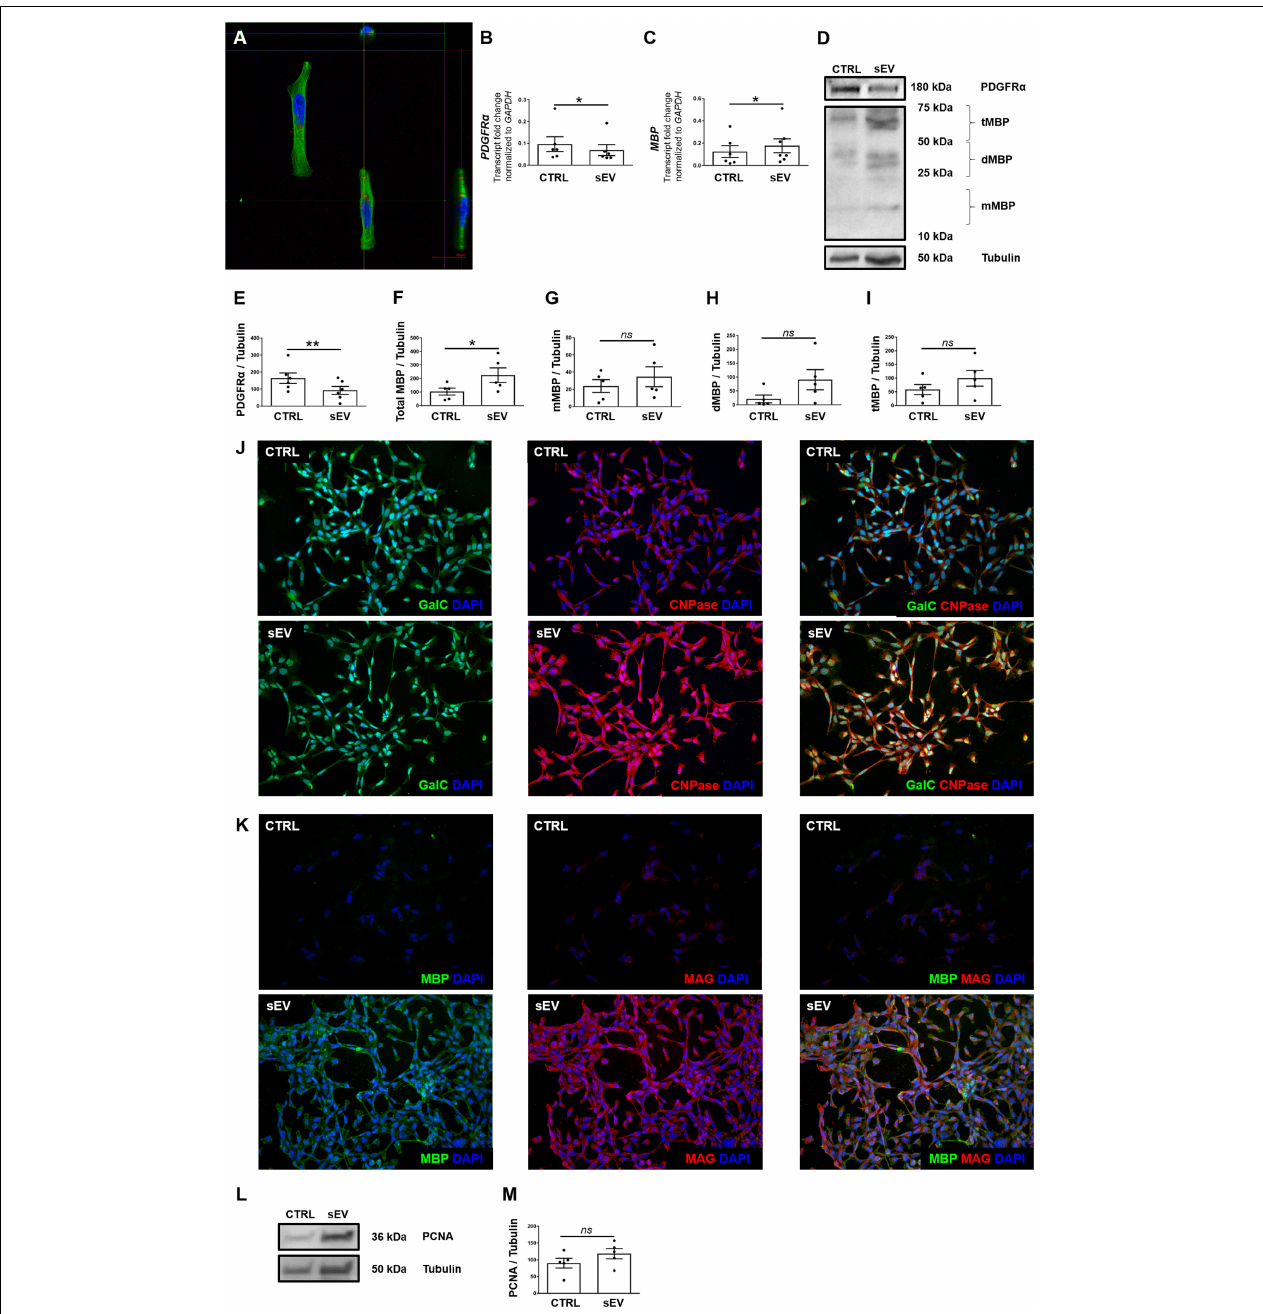
FIGURE 1 | WJ-MSC-derived sEV co-localize with MO3.13 cells and drive their maturation. (A) Representative confocal Z-stack section after co-culture of sEV with MO3.13 cells for 4 h. To label sEV, the fluorescent membrane dye PKH26 (red) was used. MO3.13 cells were stained with β -tubulin (green). Their nuclei were counterstained with 4 (cid:48) ,6-diamidino-2 (cid:48) -phenylindole-dihydrochloride (DAPI) (blue). (B,C) Transcription of PDGFR α ( n = 6) and MBP ( n = 6) by MO3.13 cells either left untreated or co-incubated with 0.5 µ g/mL sEV for 5 days. (D) Representative western blots of PDGFR α and MBP expression by MO3.13 cells either left untreated or co-cultured with 5 µ g/mL sEV for 5 days. (E) Quantification of PDGFR α protein expression by MO3.13 cells after 5 days ( n = 6) (F–I) Quantification of MBP protein expression by MO3.13 cells after 5 days ( n = 5). (J,K) Representative fluorescence microscopy images of either untreated or sEV-treated MO3.13 cells after 5 days for the expression of GalC, CNPase, MBP, and MAG. Their nuclei were counterstained with DAPI. (L) Representative western blot of PCNA expression by MO3.13 cells either left untreated or co-cultured with 5 µ g/mL sEV for 5 days. (M) Quantification of PCNA protein expression by MO3.13 cells after 5 days ( n = 5). Data are presented as mean ± SEM. * p < 0.05, ** p < 0.01, ns, non-significant.